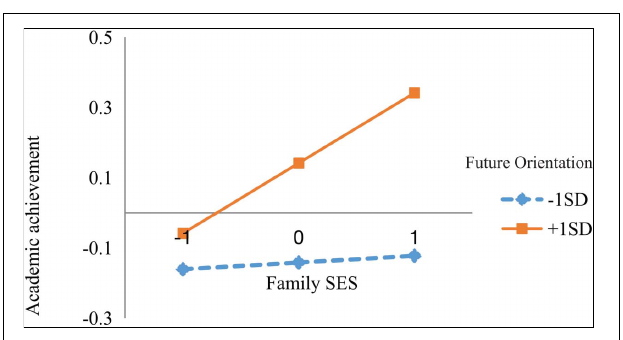
achievement is mediated by Internet usage preference for entertainment, and this effect is moderated by adolescent’s future orientation.